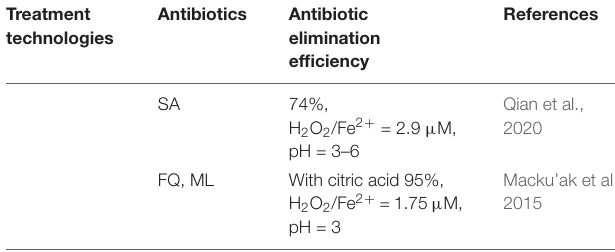
TABLE 3 | Antibiotic elimination efficiencies in different treatment